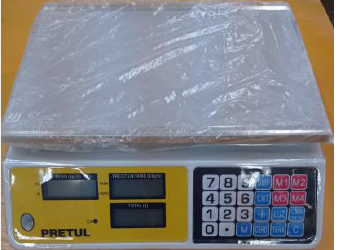
Figure 9. Digital scale with a 40 kg weighing capacity.